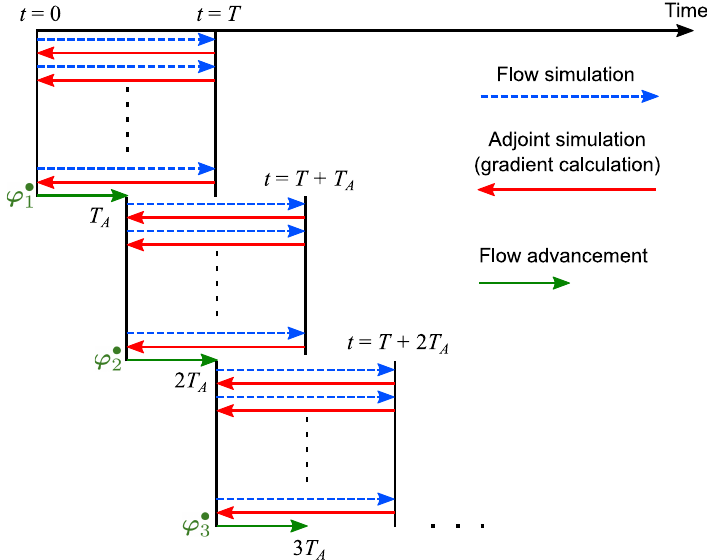
Figure 2. Receding horizon framework subdividing time into discrete flow advancement windows of length T A with prediction horizon T . Each arrow represents a forward or adjoint PDE simulation. Each window consists of an optimization stage (blue and red lines), yielding a set of optimal controls ϕ • , followed by a flow advancement stage (green line). Figure originally published in Munters and Meyers [14] under a CC-BY 4.0